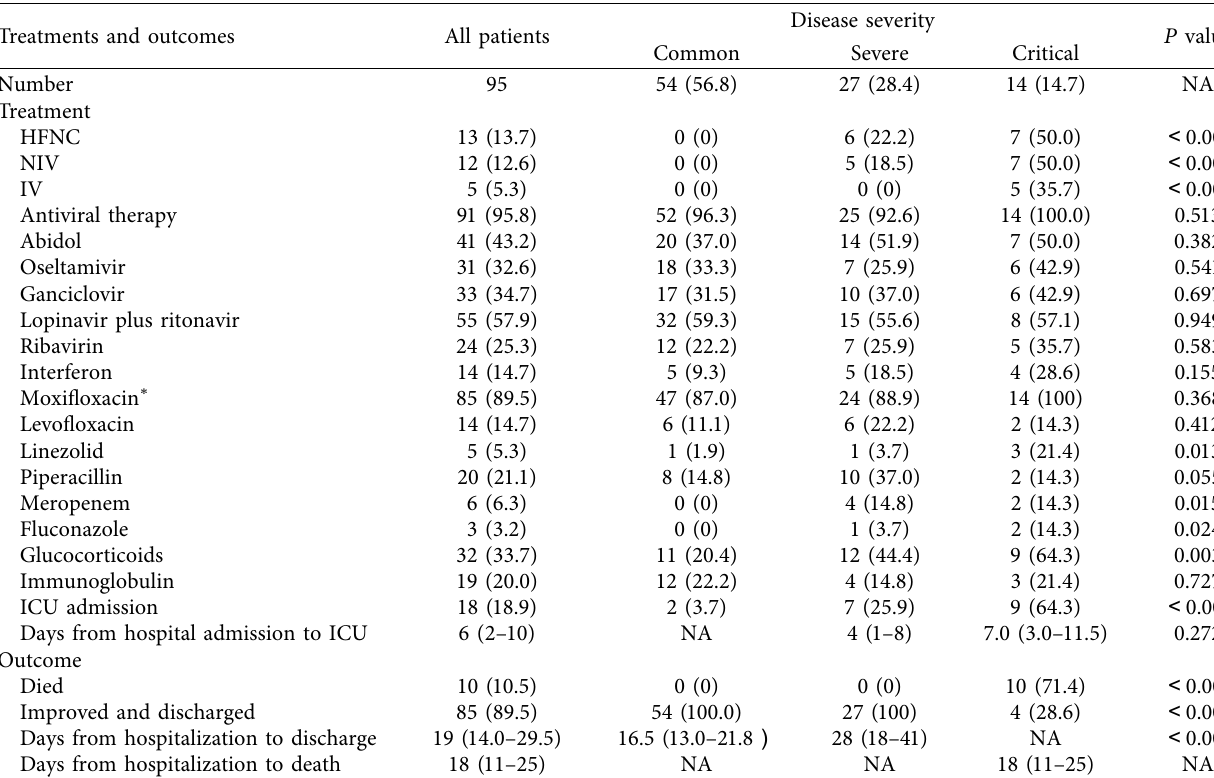
Table 4: Treatments and outcomes of COVID-19